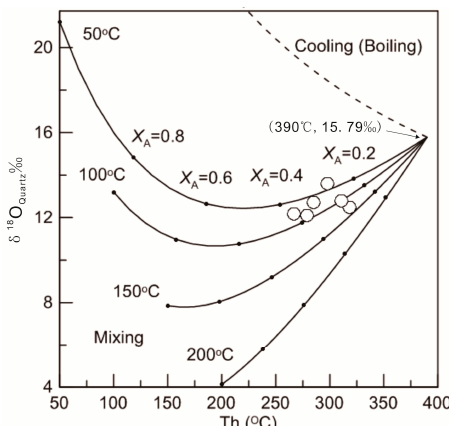
Figure 6. Diagram showing the influence of boiling and mixing on the oxygen isotopic composition of quartz precipitated at different temperatures. Numbers denote mass fraction of meteoric water.